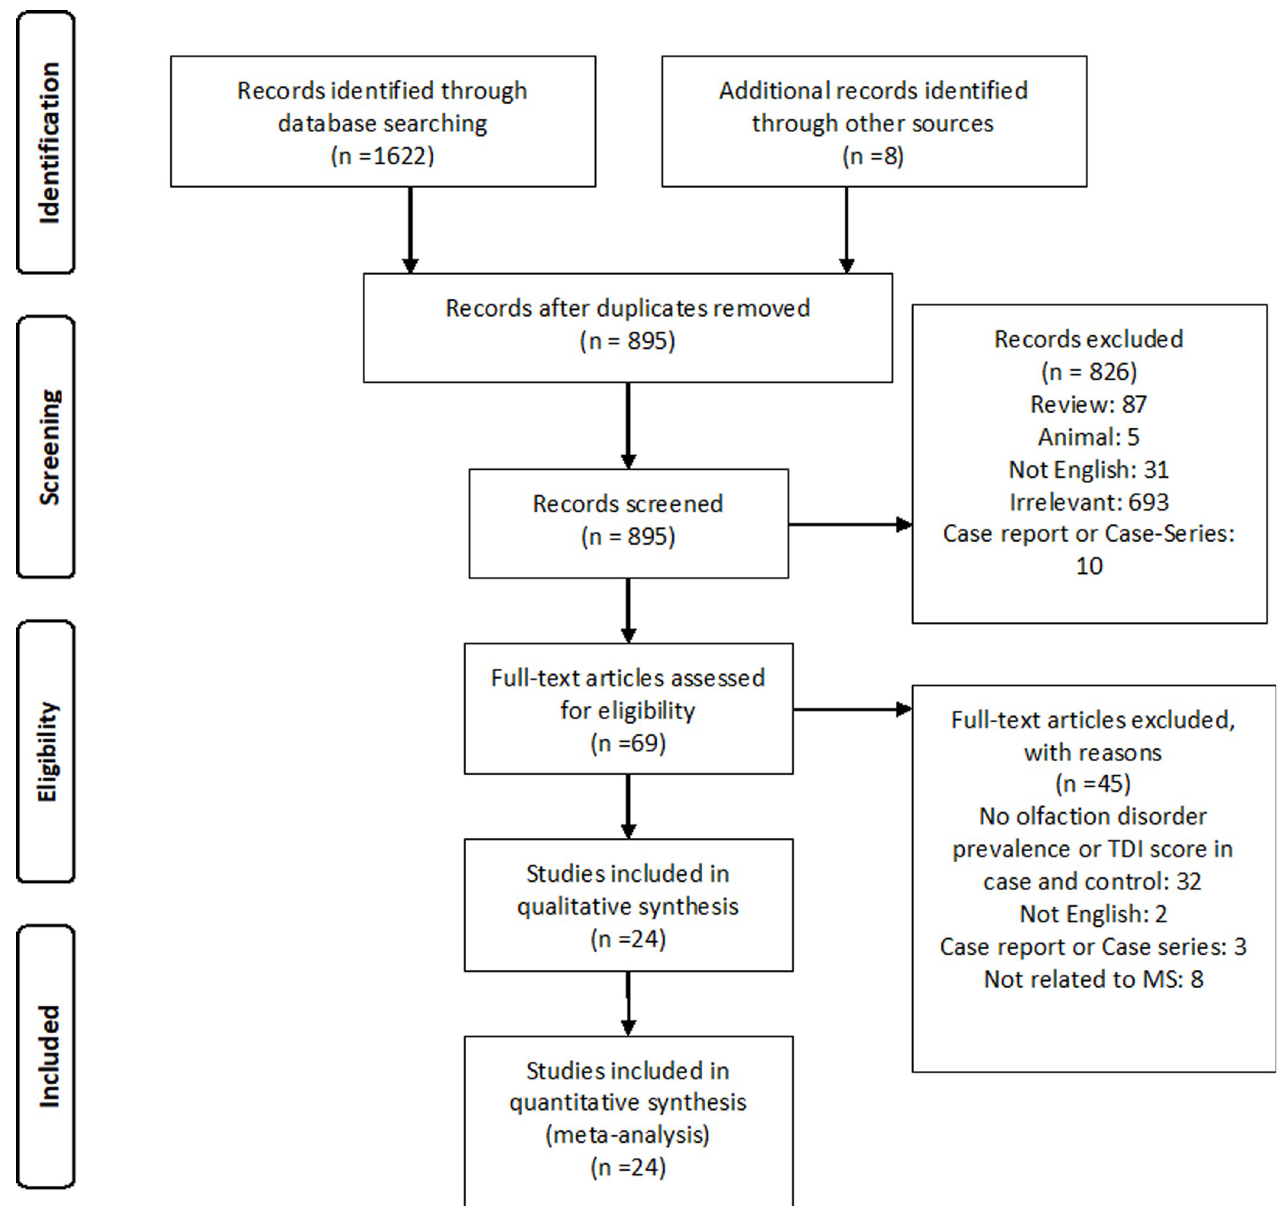
Fig 1. Flow diagram summarizing the selection of eligible